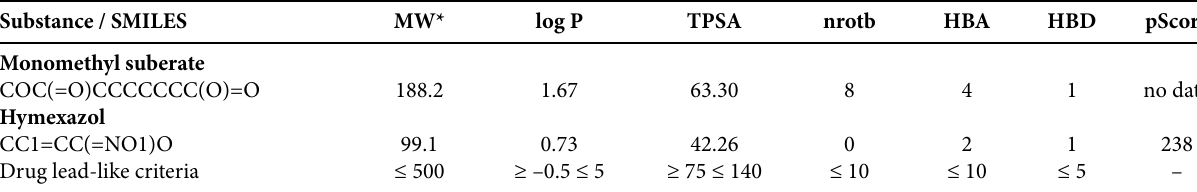
Table 1. Calculated parameters of lead-like & structure optimization and promiscuity scores Substance / SMILES MW* log